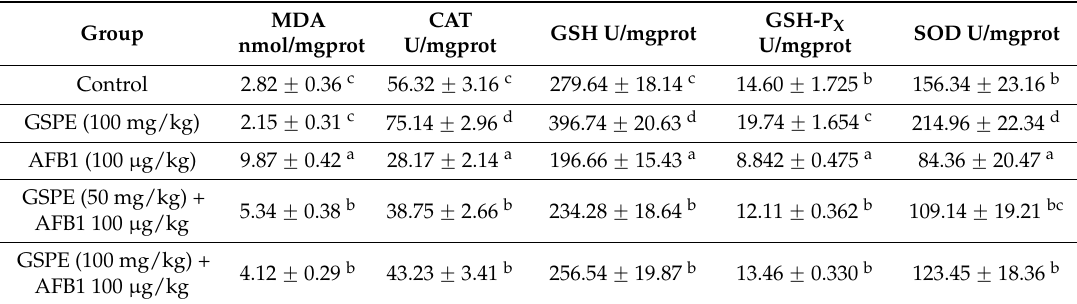
Table 2. Effect of GSPE on spleen antioxidant parameters in mice induced by AFB1.